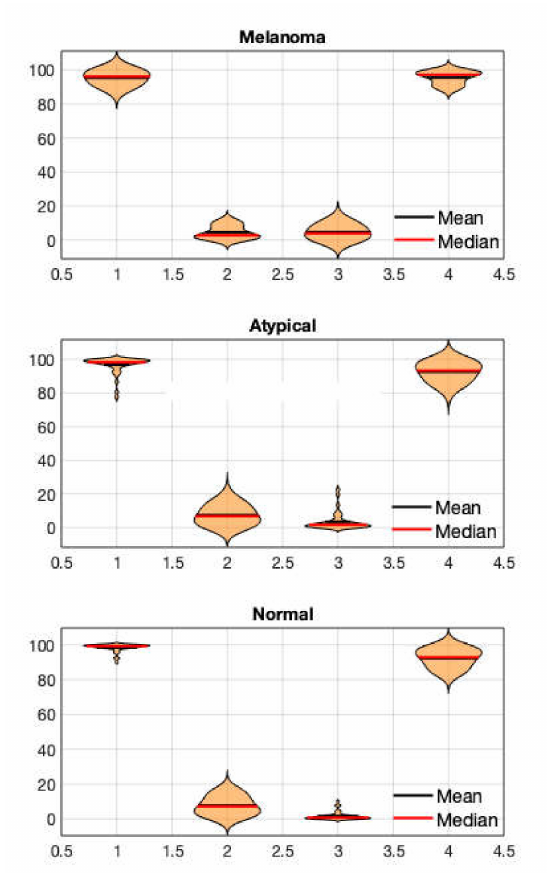
Figure 4. The violin plots of TN, TP, FN, and FP statistics for melanoma, atypical, and normal skin